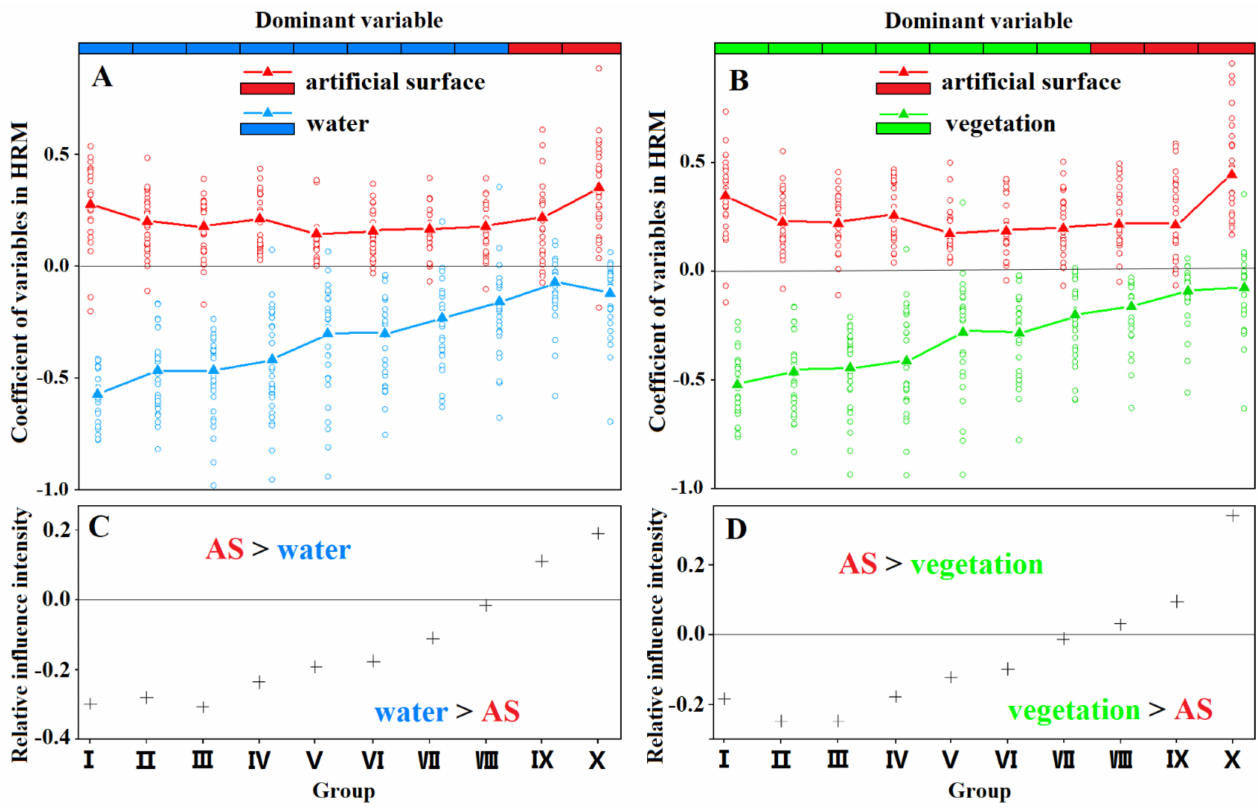
Figure 6. Overall HRM statistics for the 28 urban areas, as well as the dominating variable in each group. The HRM findings for water (or vegetation) and AS are shown in ( A , B ). ( C , D ) The impact of the relative intensity of water (or vegetation) and AS on LST. The hollow circle represents the regression coefficient for each individual urban area, while the solid triangles reflect the mean of all the regression coefficients. The red, blue, and green bars in the bar chart above the graphic demonstrate that AS, water, and vegetation are the dominant variables in this group,